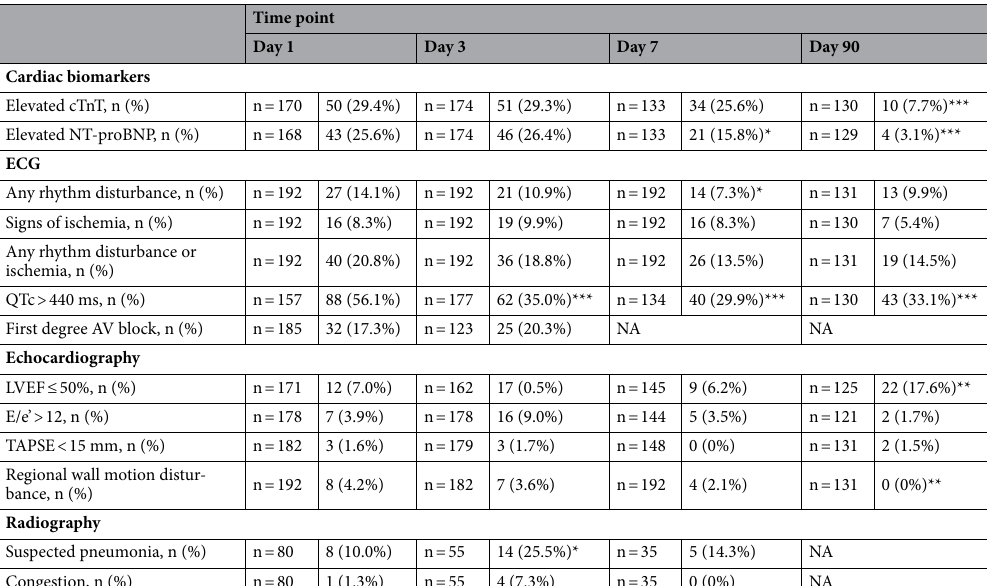
Table 4. Cardiac and other complications during admission and after discharge. AV atrioventricular, cTnT cardiac troponin T, ECG electrocardiogram, LVEF left ventricular ejection fraction, NT-proBNP N ‐ terminal pro ‐ B ‐ type natriuretic peptide, QTc corrected QT interval, TAPSE tricuspid annulus plane systolic excursion.